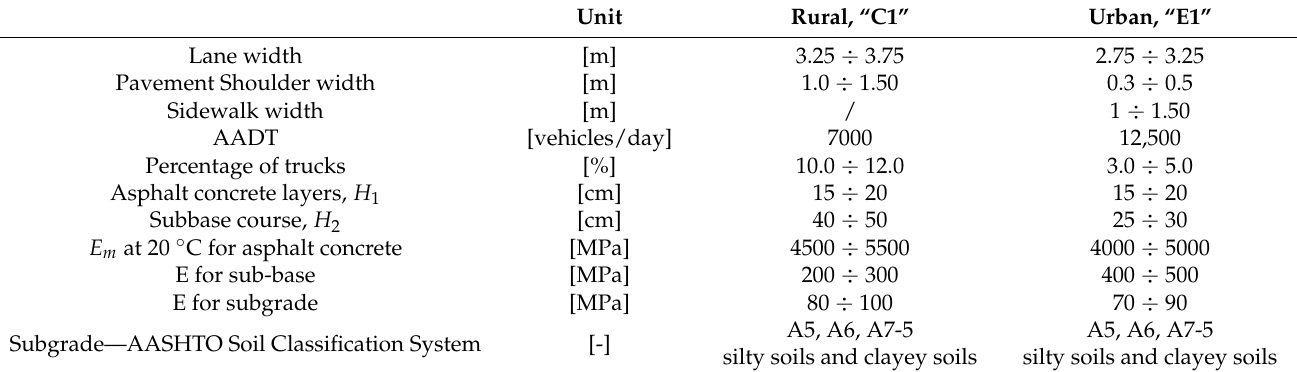
Table 2. Geometry, functional, structural, and local geotechnical information of test